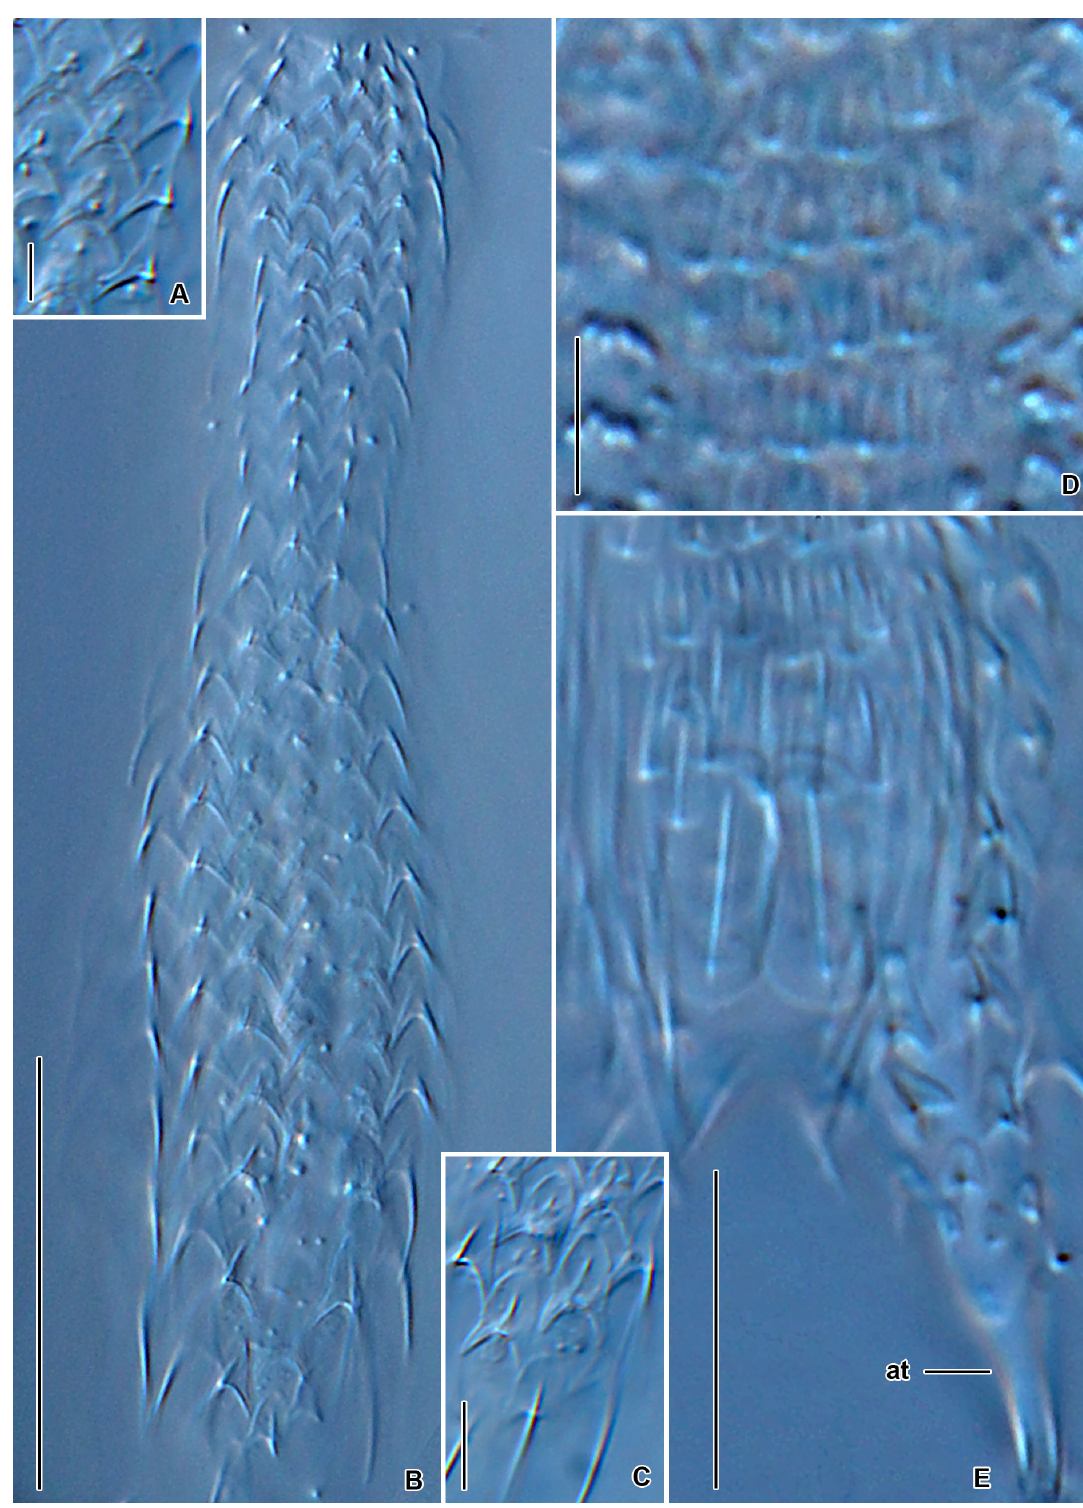
Fig. 27. Chaetonotus ( Hystricochaetonotus ) avarus sp. nov., paratype (CU-FNS-26-02-20/PA-2), differential interference contrast. A . Dorsal head scales. B . Overview showing the dorsal scale and spine pattern. C . Posterior trunk scales. D . Scales in the ventral interciliary field. E . Detail of the ventral posterior region. Scale bars: A, C–D = 5 µm; B = 30 µm; E = 15